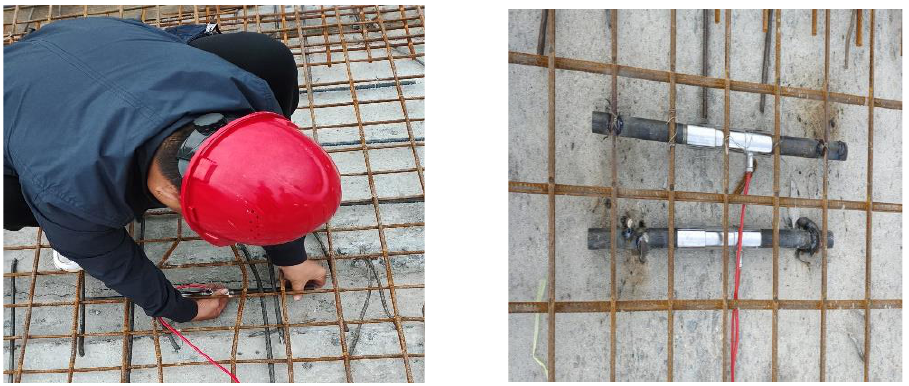
Figure 10. Gauge installation in the adhesion layer.